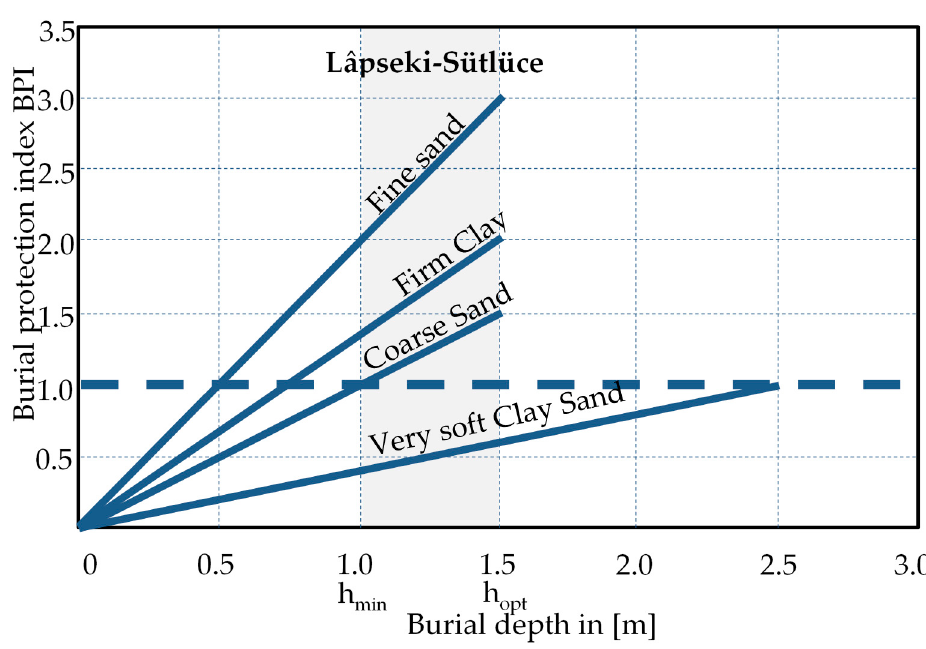
Figure 9. Burial protection index as a function of burial depth for different seabed types [29].